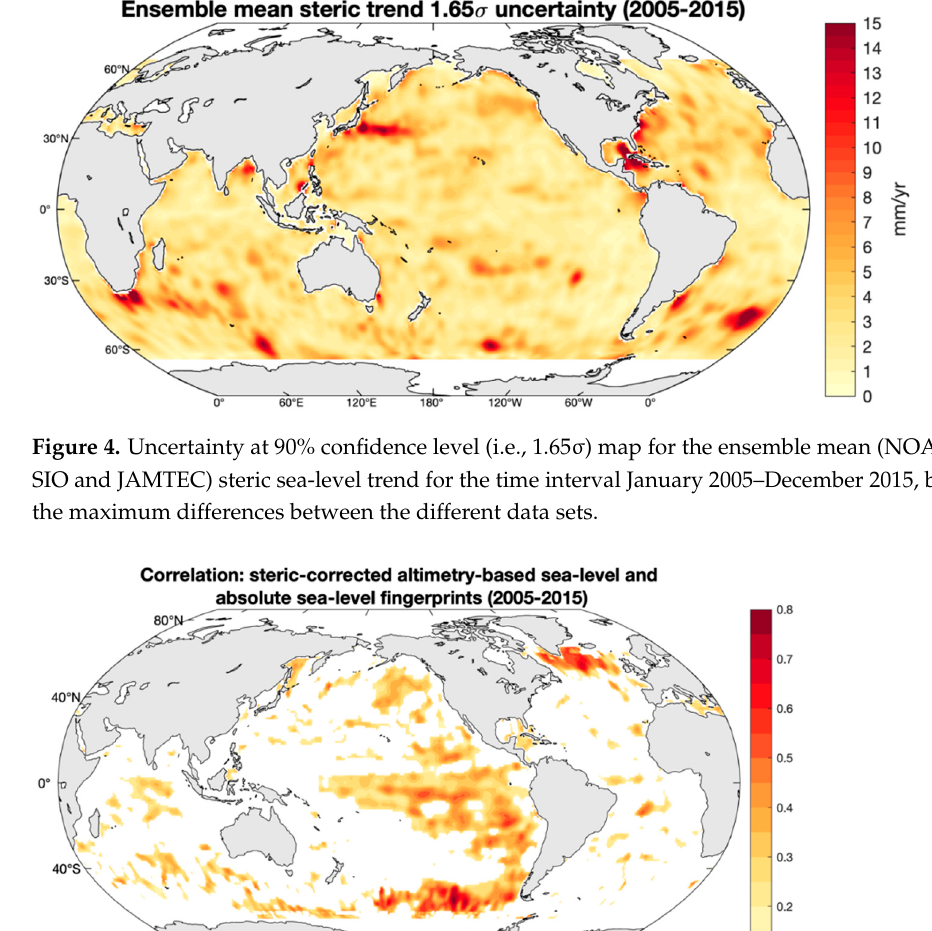
Figure 5. Pearson’s correlation map between steric-corrected altimetry and modelled absolute sea-level fingerprints time series for January 2005–December 2015. The map only shows positive correlations that are statistically significant at 95% confidence level.